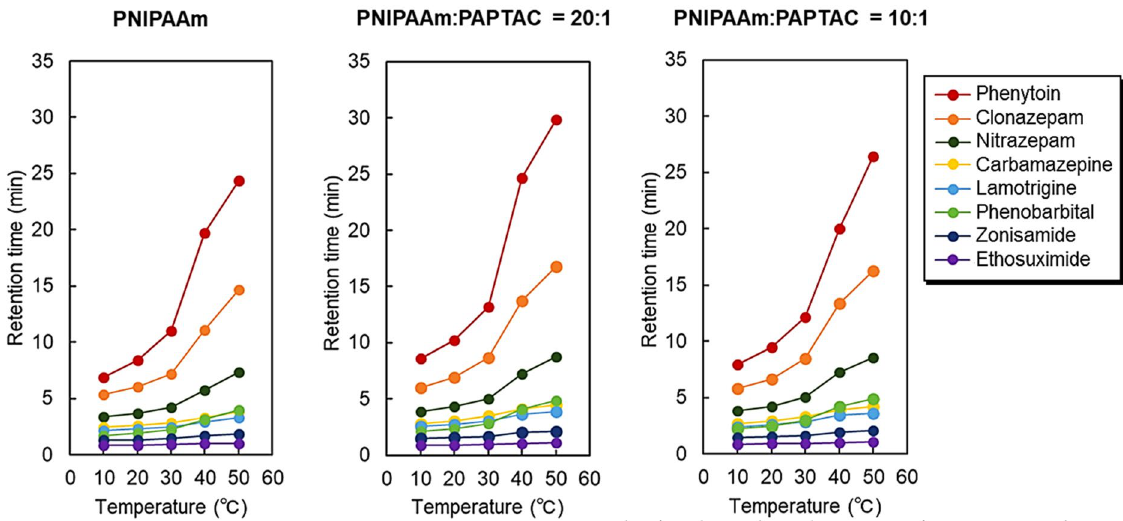
Figure 6. Retention times of the antiepileptic drugs on the prepared mixed-mode columns. (Figures were drawn Microsoft PowerPoint 2019 Version